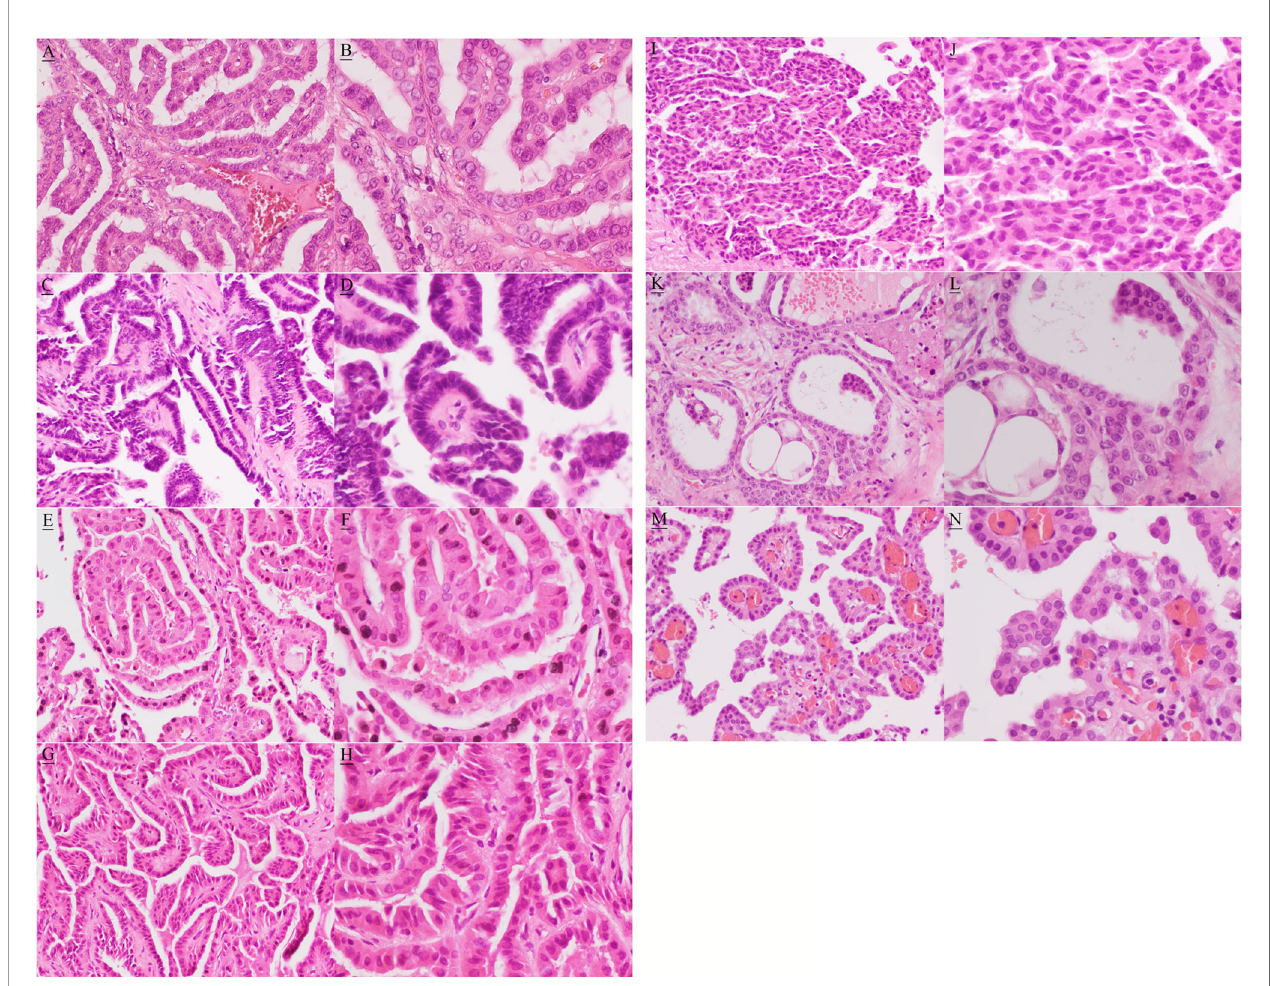
FIGURE 2 | Hematoxylin and eosin image showing conventional ( A , magni fi cation, x200; B , magni fi cation, x400), columnar ( C , magni fi cation, x200; D , magni fi cation, x400), tall cell ( E , magni fi cation, x200; F , magni fi cation, x400), cribriform-morular ( G , magni fi cation, x200; H , magni fi cation, x400), solid/trabecular ( I , magni fi cation, x200; J , magni fi cation, x400), follicular ( K , magni fi cation, x200; L , magni fi cation, x400), and hobnail ( M , magni fi cation, x200; N , magni fi cation, x400) morphological